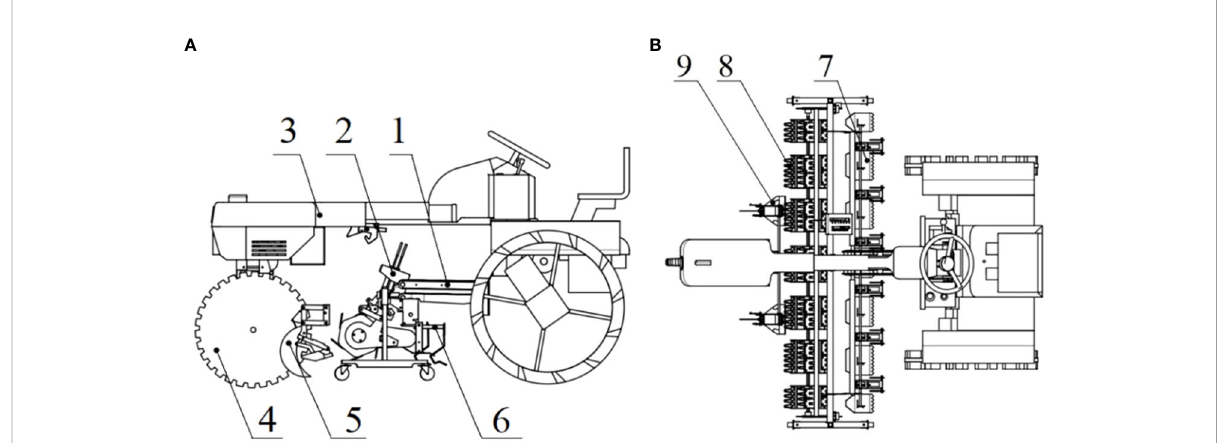
FIGURE 1 Schematic diagram of a paddy fi eld weeding device: (A) top view; (B) bottom view. (1. Suspension device. 2. Hoeing-depth-adjusting device. 3. Frame. 4. Walking device. 5. Anti-winding knife. 6. Intra-row weeding device. 7. Mud scraper. 8. Inter-row weeding device. 9. Depth-limit